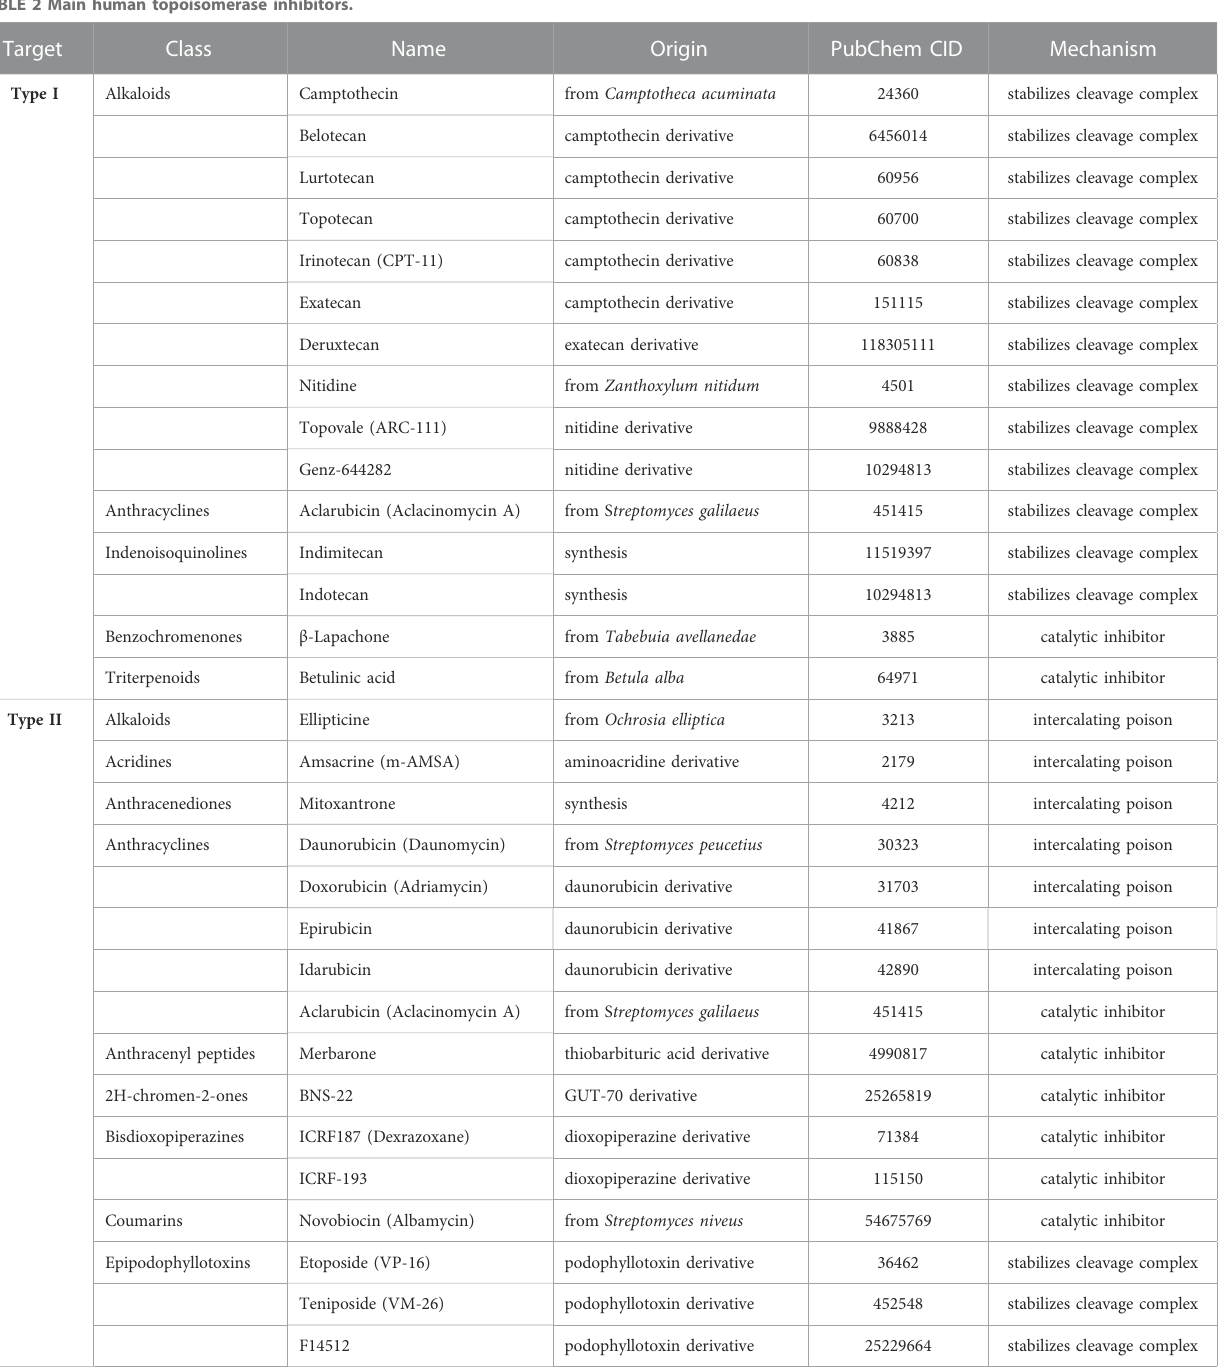
TABLE 2 Main human topoisomerase